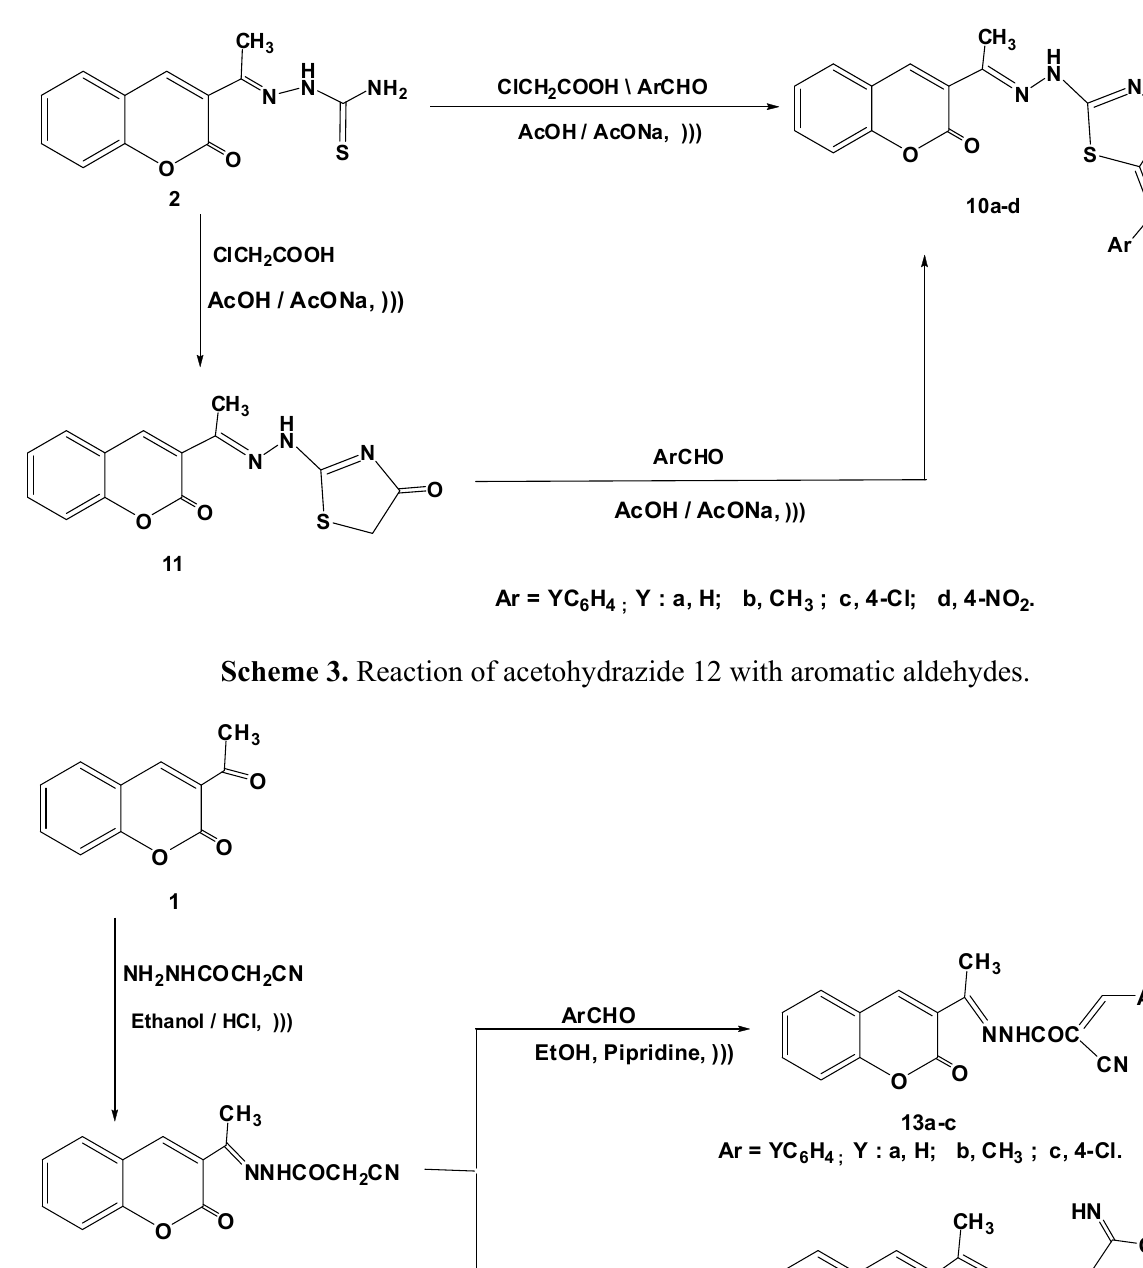
Scheme 2. Synthesis of 5-arylidenethiazolinone derivatives 10a – d .